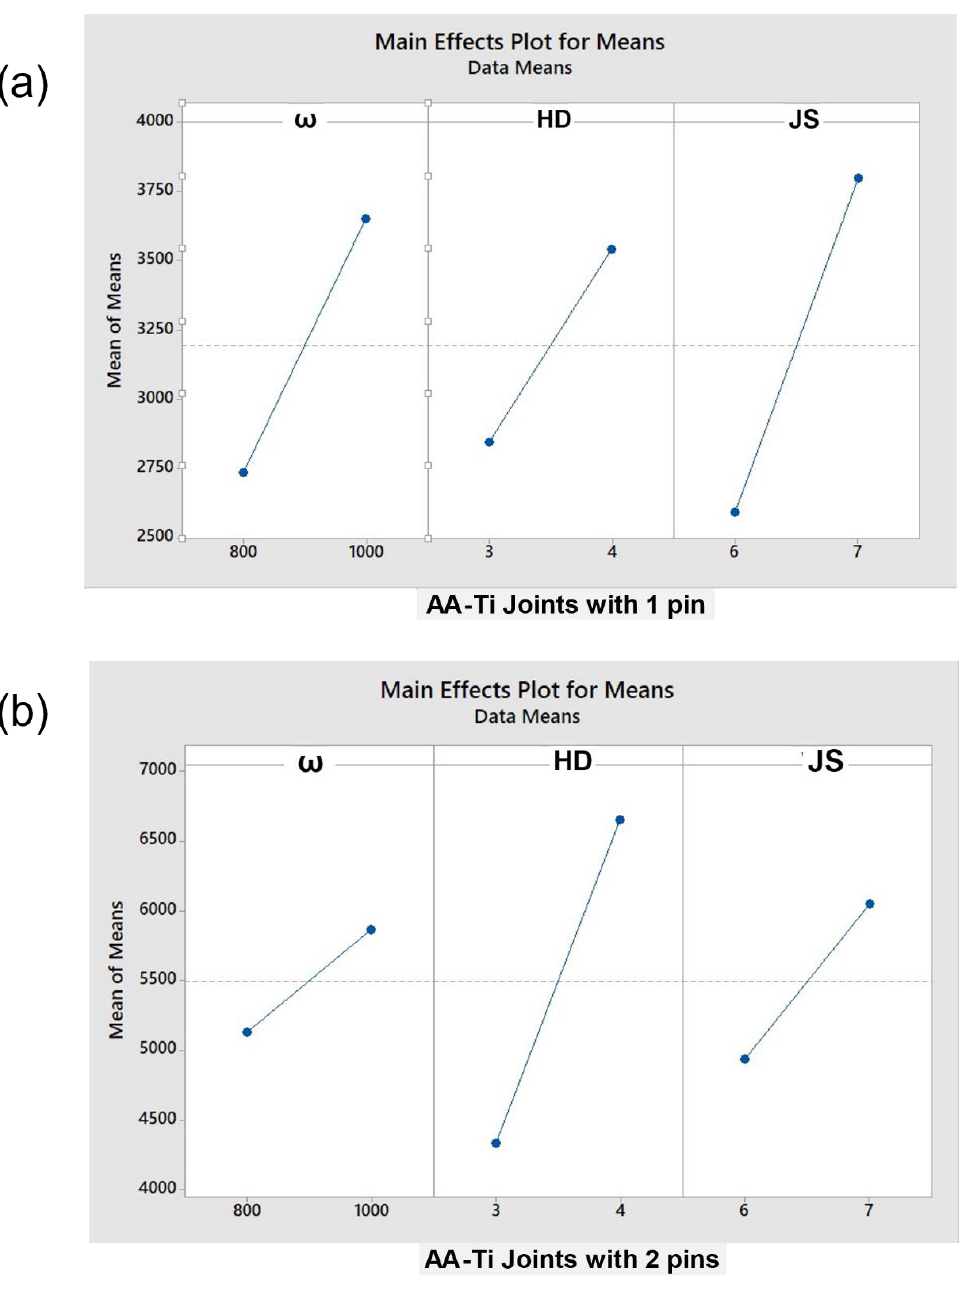
Figure 9. Plots of the mean effect of the process parameters on the UTLF in the ( a ) AA-Ti joints with one and ( b ) AA-Ti joints with two connections points.